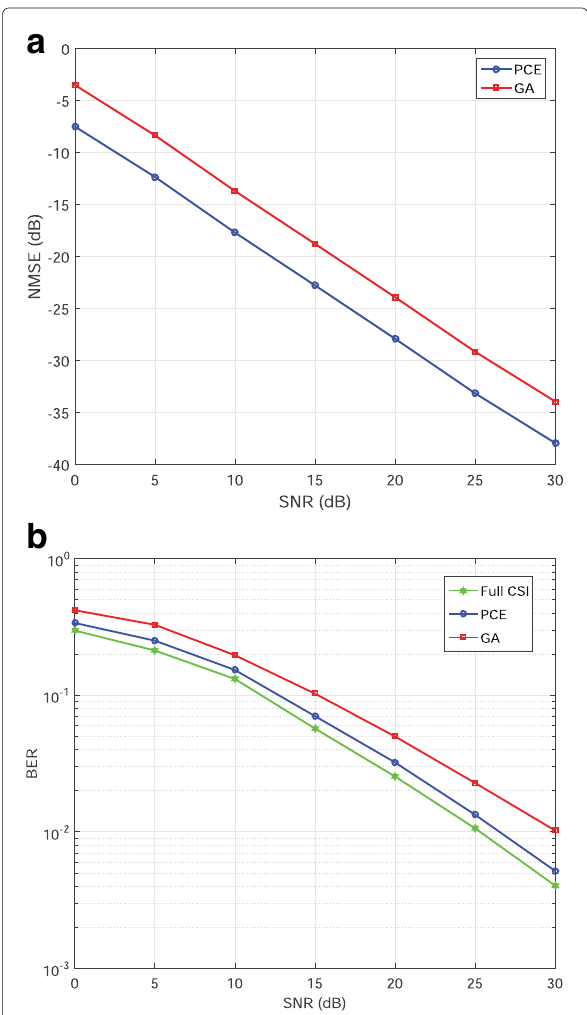
Fig. 5 Performance comparison of proposed method and GA-based pilot allocation algorithm. a NMSE performance metric and b BER performance